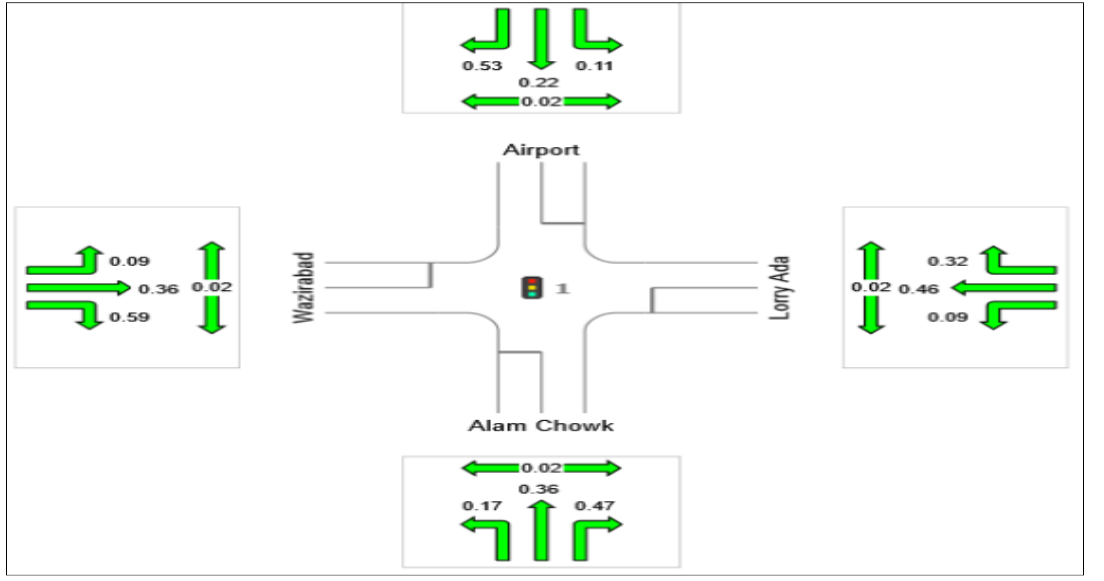
Fig. 13. Degree of Saturation in Modified Condition at Gulistan Cinema